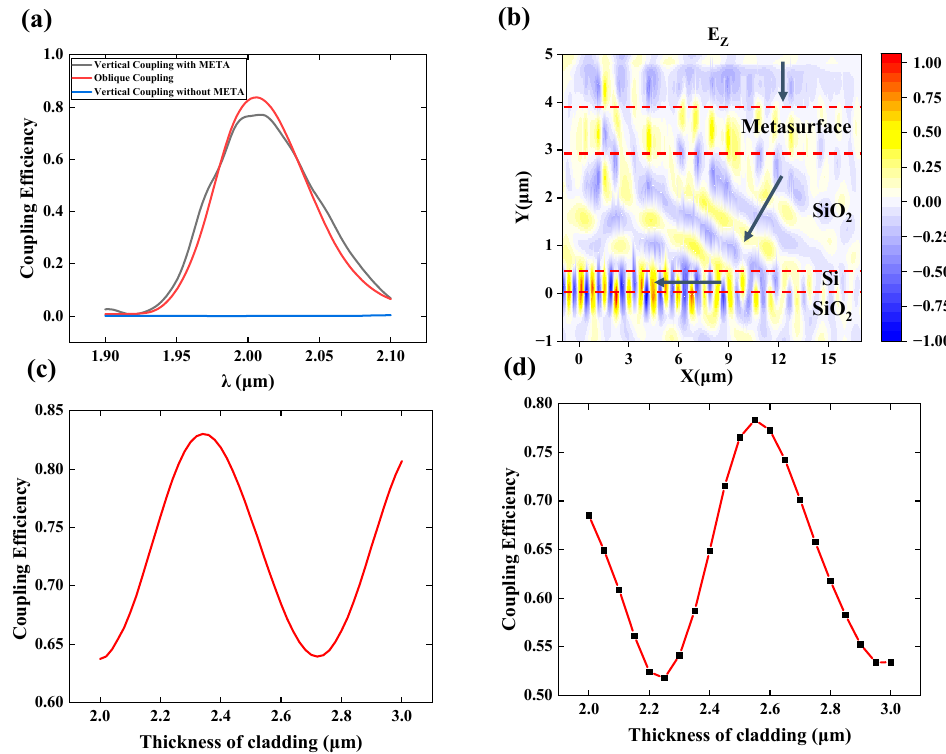
Figure 4. ( a ) The CE of perfectly vertical coupling with meta-deflector, without meta-deflector, and oblique incidence coupling (18.5 ◦ ). ( b ) The Ez field propagation of perfectly vertical coupling with meta-deflector at the wavelength of 2 µ m (the arrows mark the direction of light). ( c ) The relationship between the T c and the CE without meta-deflector. ( d ) The relationship between the T c and the CE with meta-de fl ector.